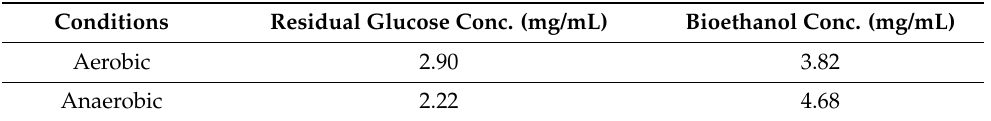
Table 2. The concentration of glucose and bioethanol concentration after 72 h of incubation of G4 yeast isolates with cellulosic fiber waste hydrolysate under aerobic and anaerobic conditions. Conditions